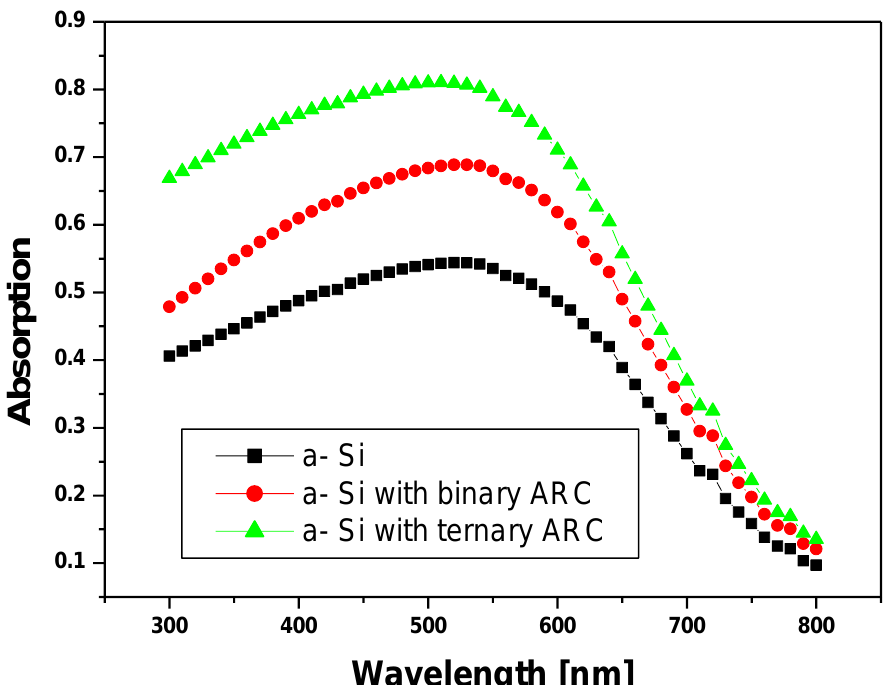
Figure 3. Hydrogenated amorphous silicon solar cell (a-Si: H) absorption spectrum with anti-reflective coating The binary ARC is composed of silicon dioxide deposed on titanium dioxide with thickness 54 nm and 82 nm, respectively. Also, the ternary ARC is composed of silicon nitride with a thickness of 33 nm immersed between silicon dioxide and titanium dioxide with thicknesses 54 nm and 82 nm, respectively.